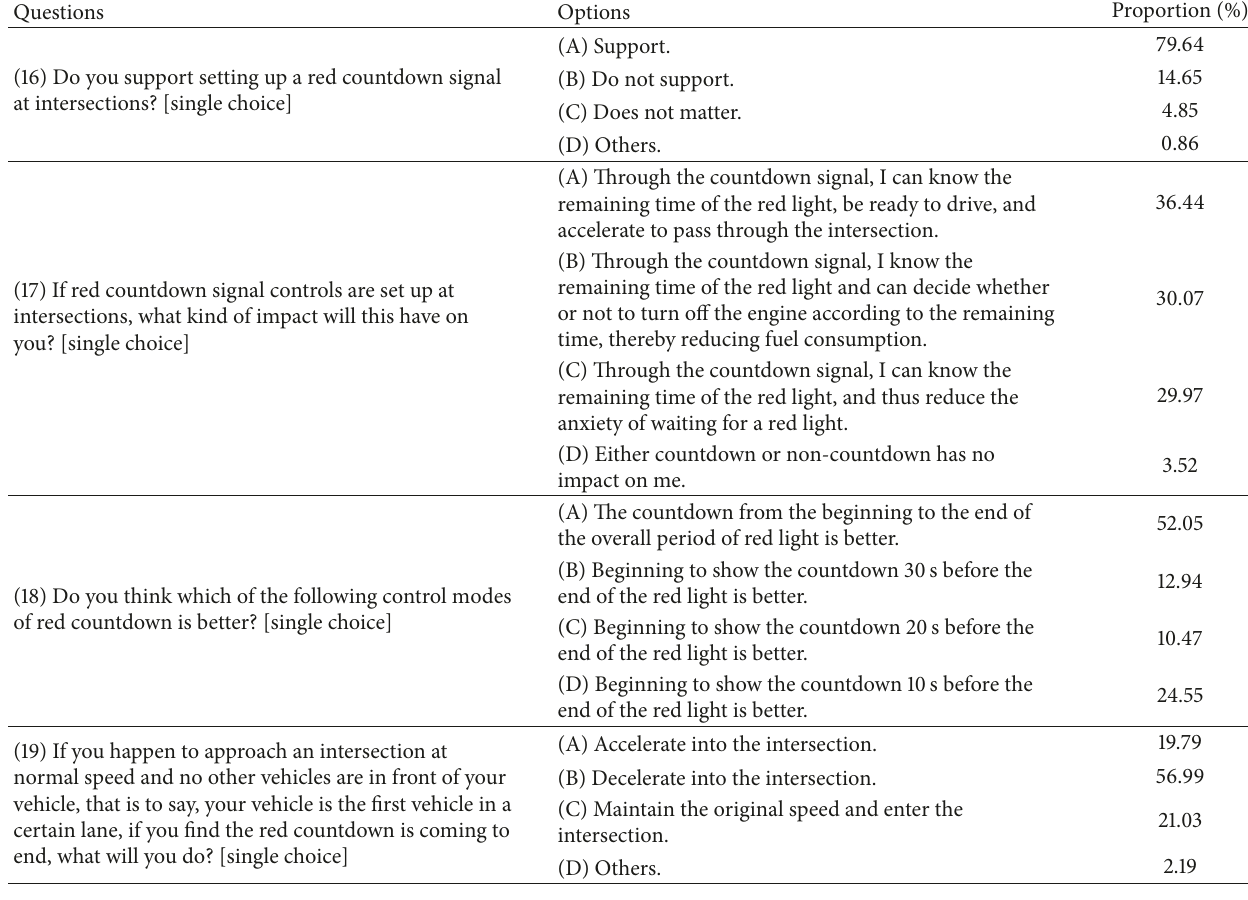
Table 5: Attitudes and behaviors of surveyed drivers on red countdown signal controls.